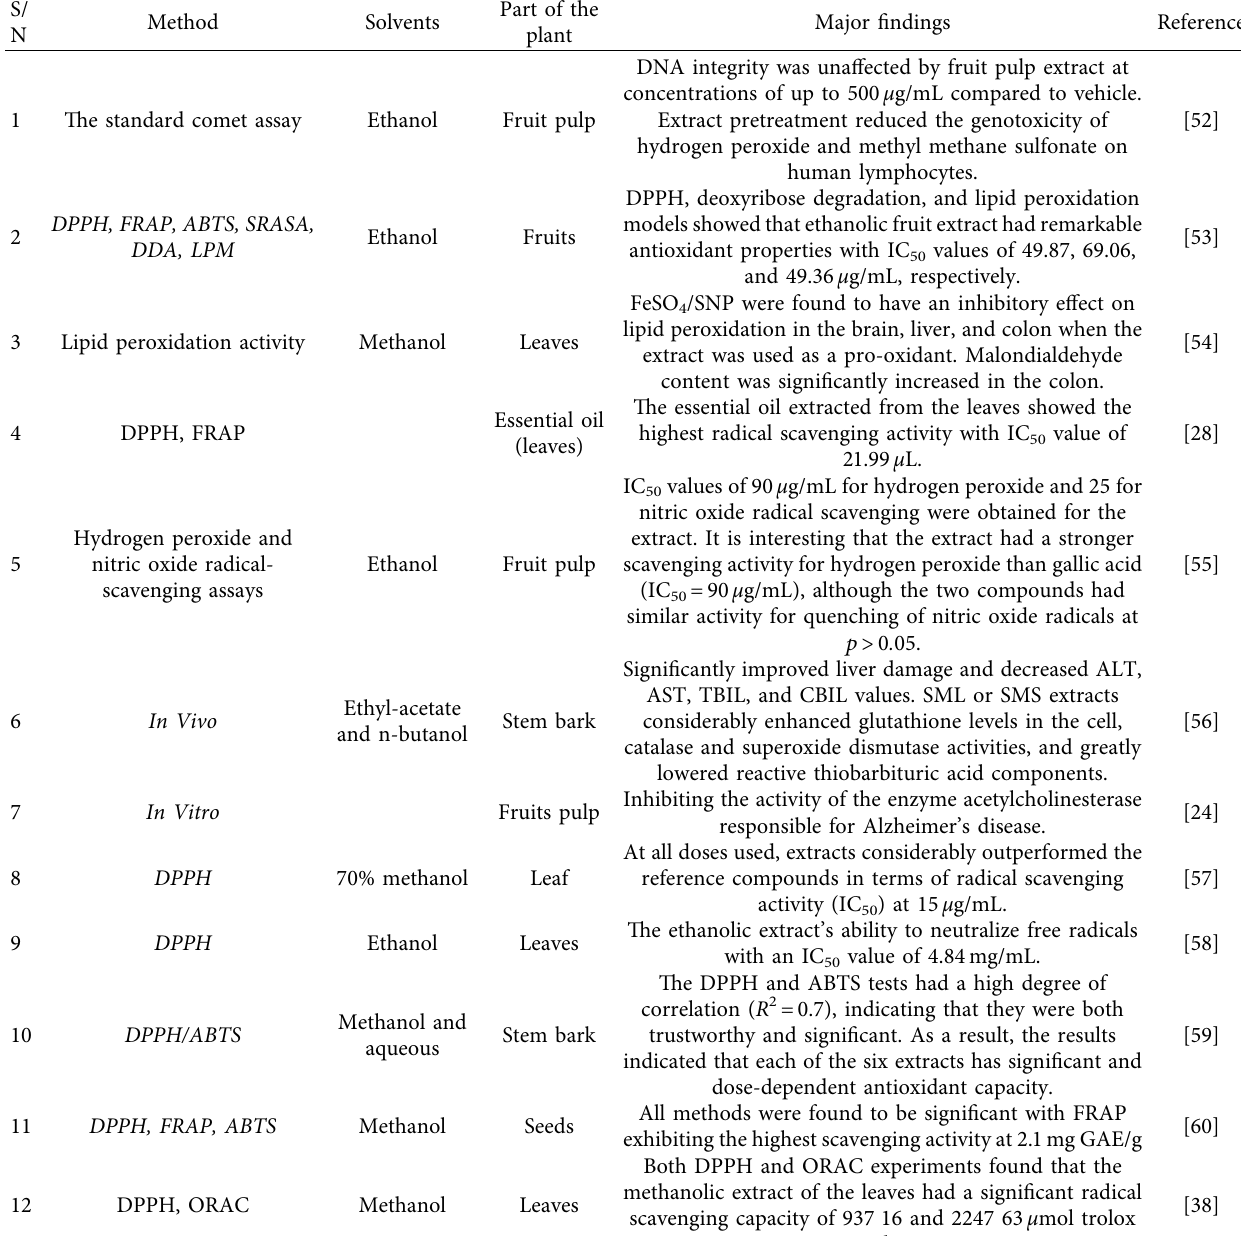
Table 2: Antioxidant activity of D. microcarpum